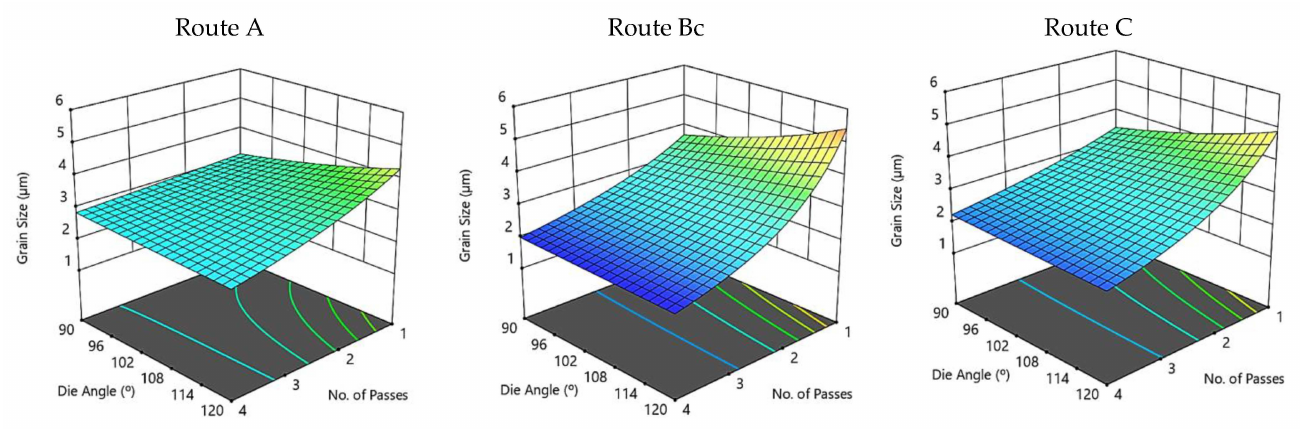
Figure 4. Three-dimensional plot of grain size with ECAP die angle and number of passes at routes A, Bc, and